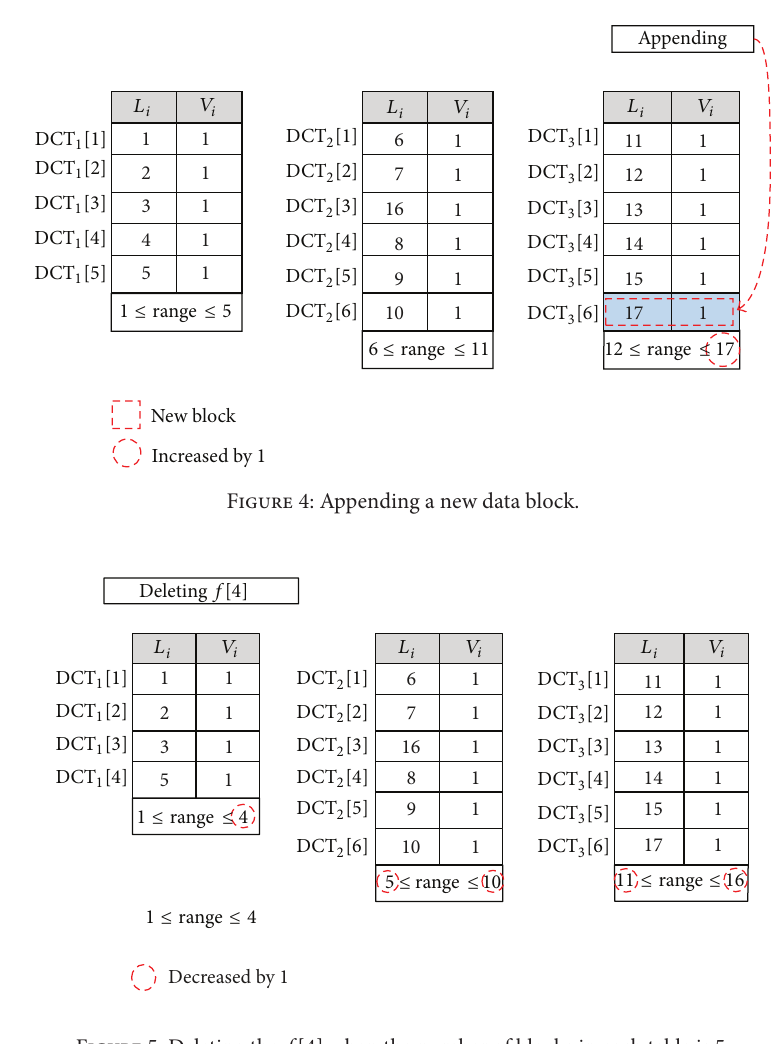
Figure 5: Deleting the 𝑓[4] when the number of blocks in each table is